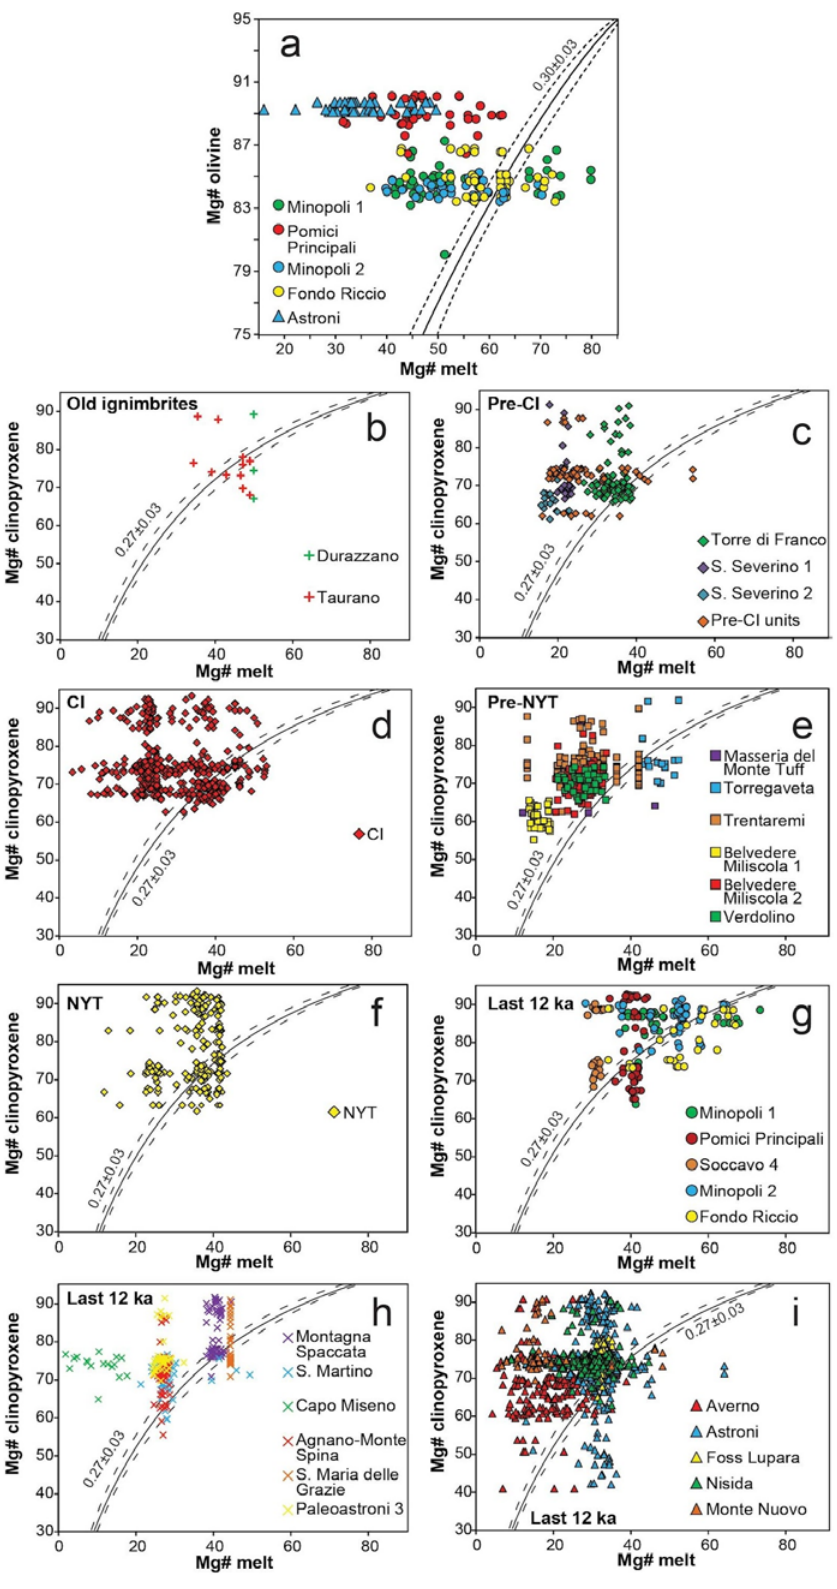
Figure 7. Equilibrium test 1 based on the Fe-Mg partitioning between olivine or clinopyroxene and melt ( Fe-Mg Kd ol-liq = 0.30 ± 0.03 and Fe-Mg Kd cpx-liq = 0.27 ± 0.03 [13,15,28,123,125] for Campi Flegrei products of variable age. ( a ) olivine-melt equilibrium test; clinopyroxene-melt equilibrium tests for products belonging to Old ignimbrites ( b ), Pre-CI ( c ), CI ( d ), Pre-NYT ( e ), NYT ( f ) and last 12 ka ( g – i ).